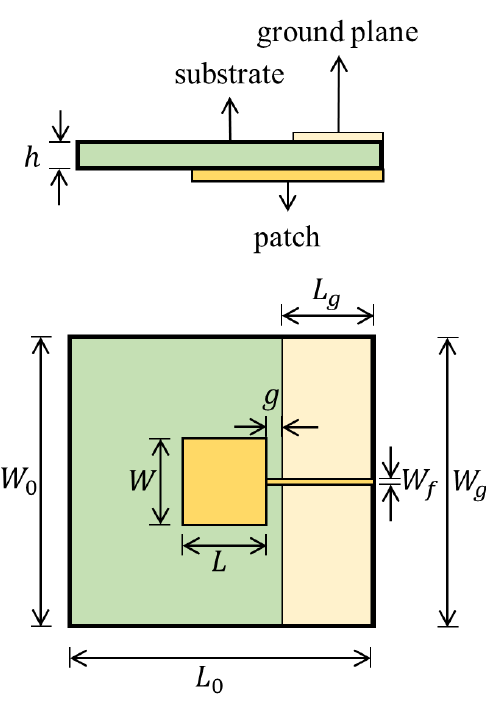
Figure 4. PMA structure.